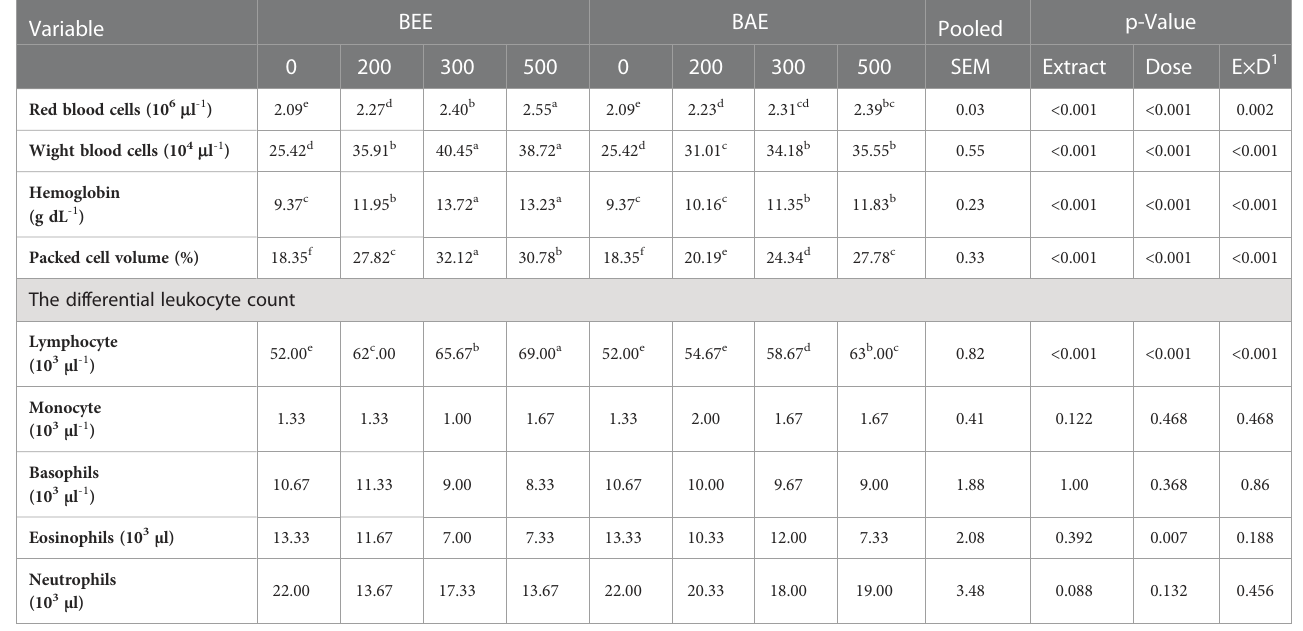
Values are means and pooled SEM. BEE: basil ethanol extract, BAE: basil aqueous extract. a-f Means in a row without a common superscript letter differ (p < 0.05) as analyzed by two-way ANOVA and the TUKEY test. 1 E × D = Extract × Dose interaction effect.